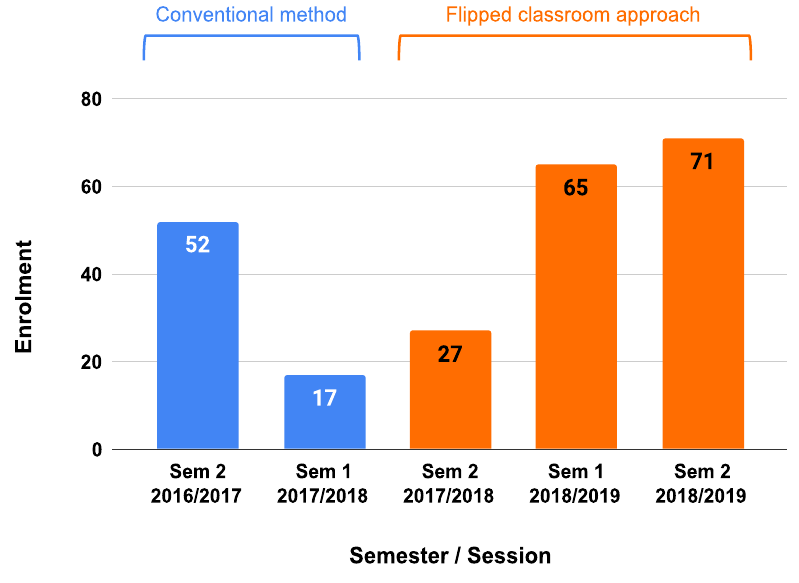
Fig. 2. Enrolment in the class of the first author each